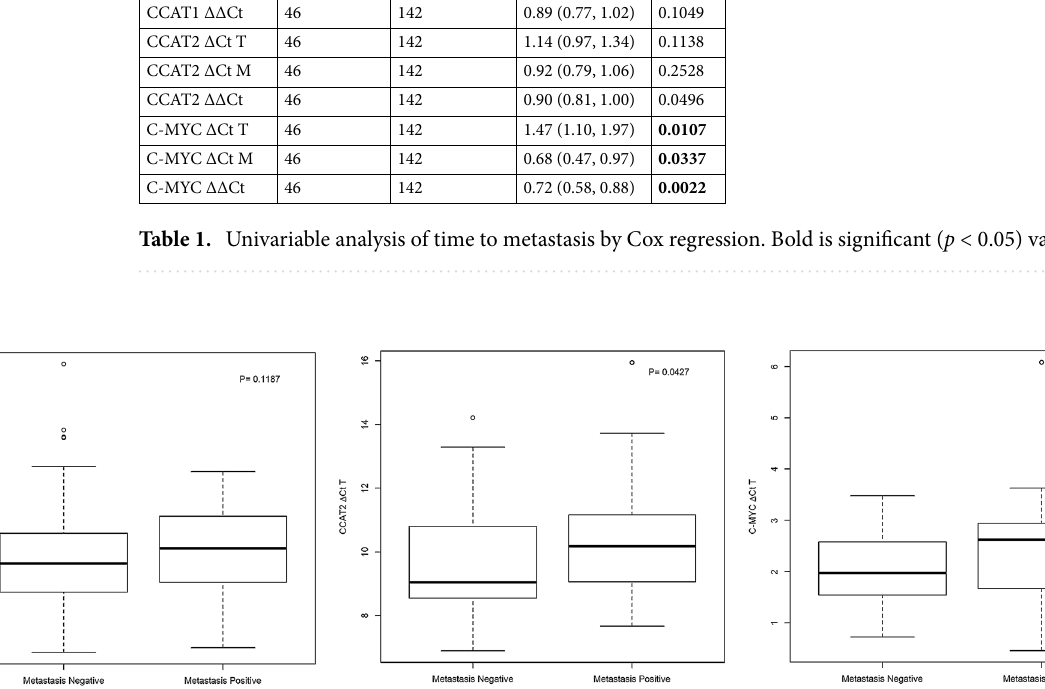
Figure 2. Boxplots of CCAT1 , CCAT2 and c-MYC expression between tumours of metastasis negative vs metastasis positive